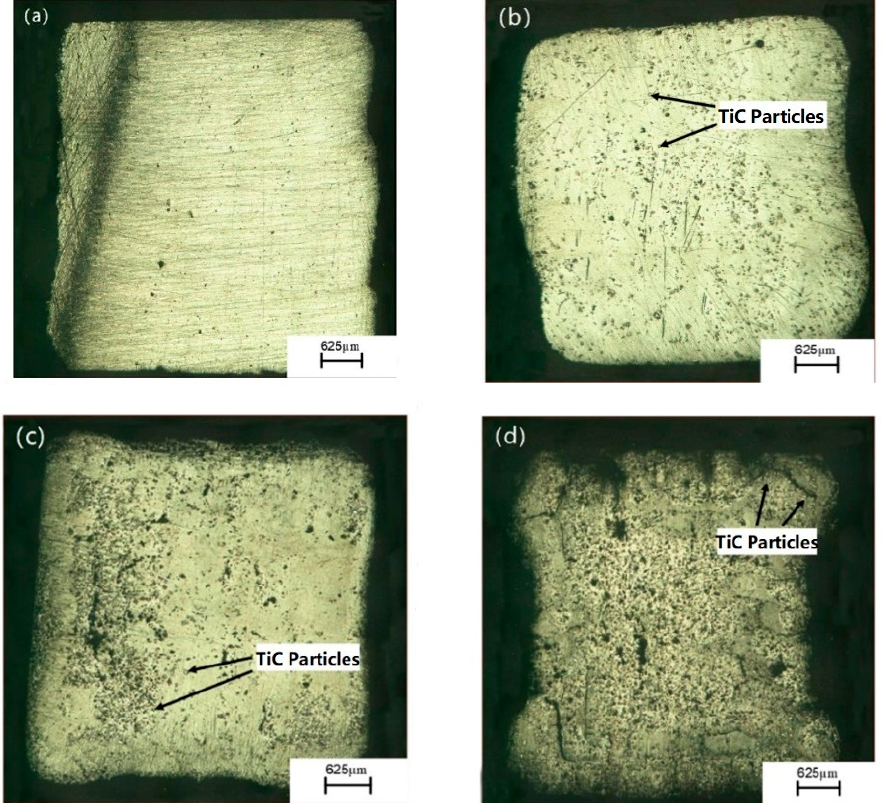
Figure 13. Sample made with different TiC powder ratios: ( a ) 0%; ( b ) 20%; ( c ) 40%; and ( d ) 60%.